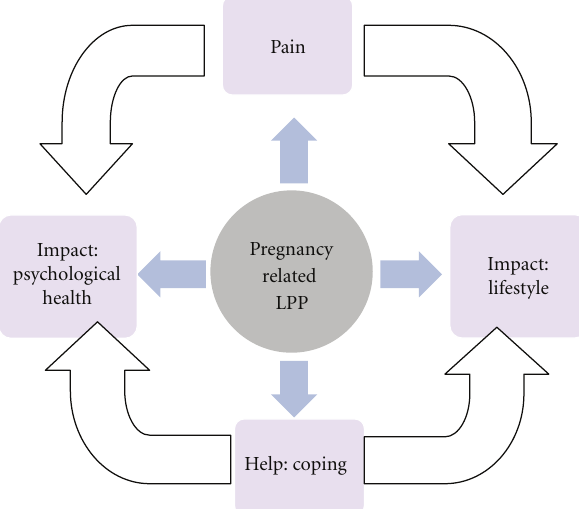
Figure 5: The relationship between pregnancy-related LPP and the four themes.